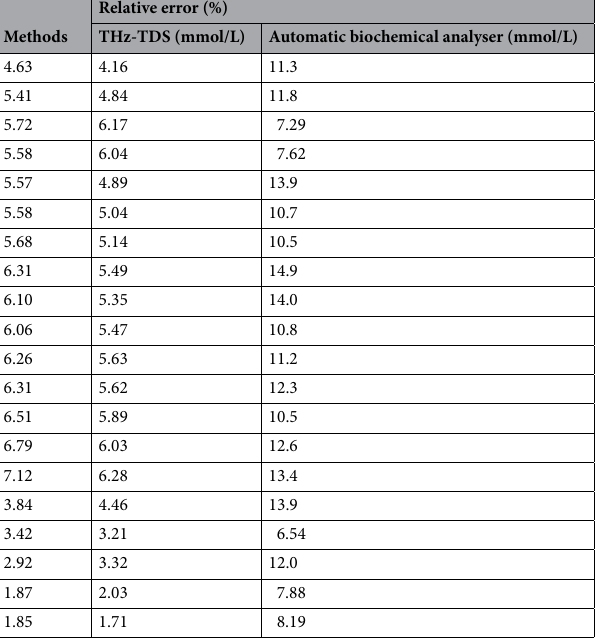
Table 3. TG contents were measured by THz-TDS and an automatic biochemical